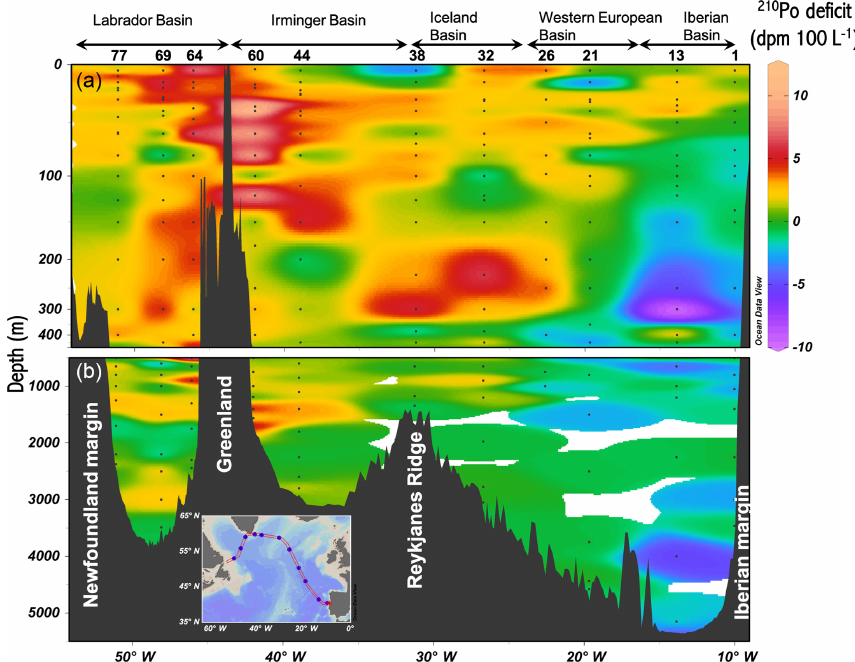
Figure 3. Section plots of water column 210 Po deficits (dpm 100L − 1 , total 210 Pb activity minus total 210 Po activity) across the GA01 transect. Panel (a) is the upper 500m. Panel (b) is 500–5500m. Station numbers and basins are shown at the top of the upper